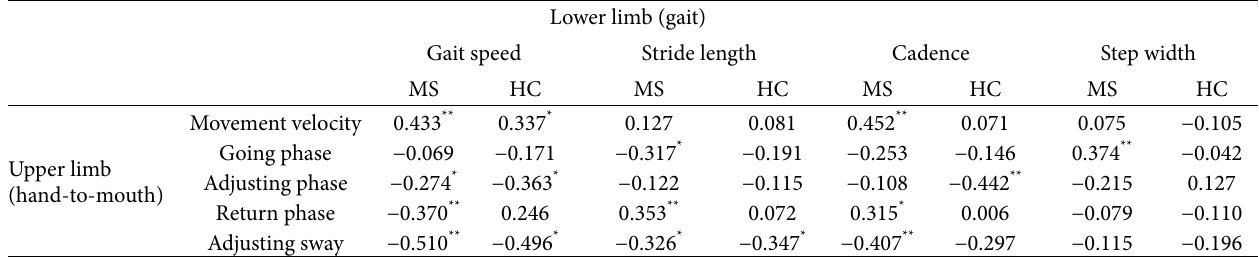
Table 3: Spearman’s rho coefficients of correlation between upper and lower limb kinematic parameters in people with multiple sclerosis (MS) and healthy controls (HC).